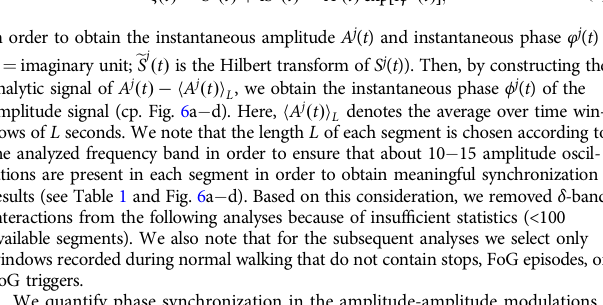
except for gender, and LEDD between PD-FoG and PD + FoG + . We note that LEDD was not available for all